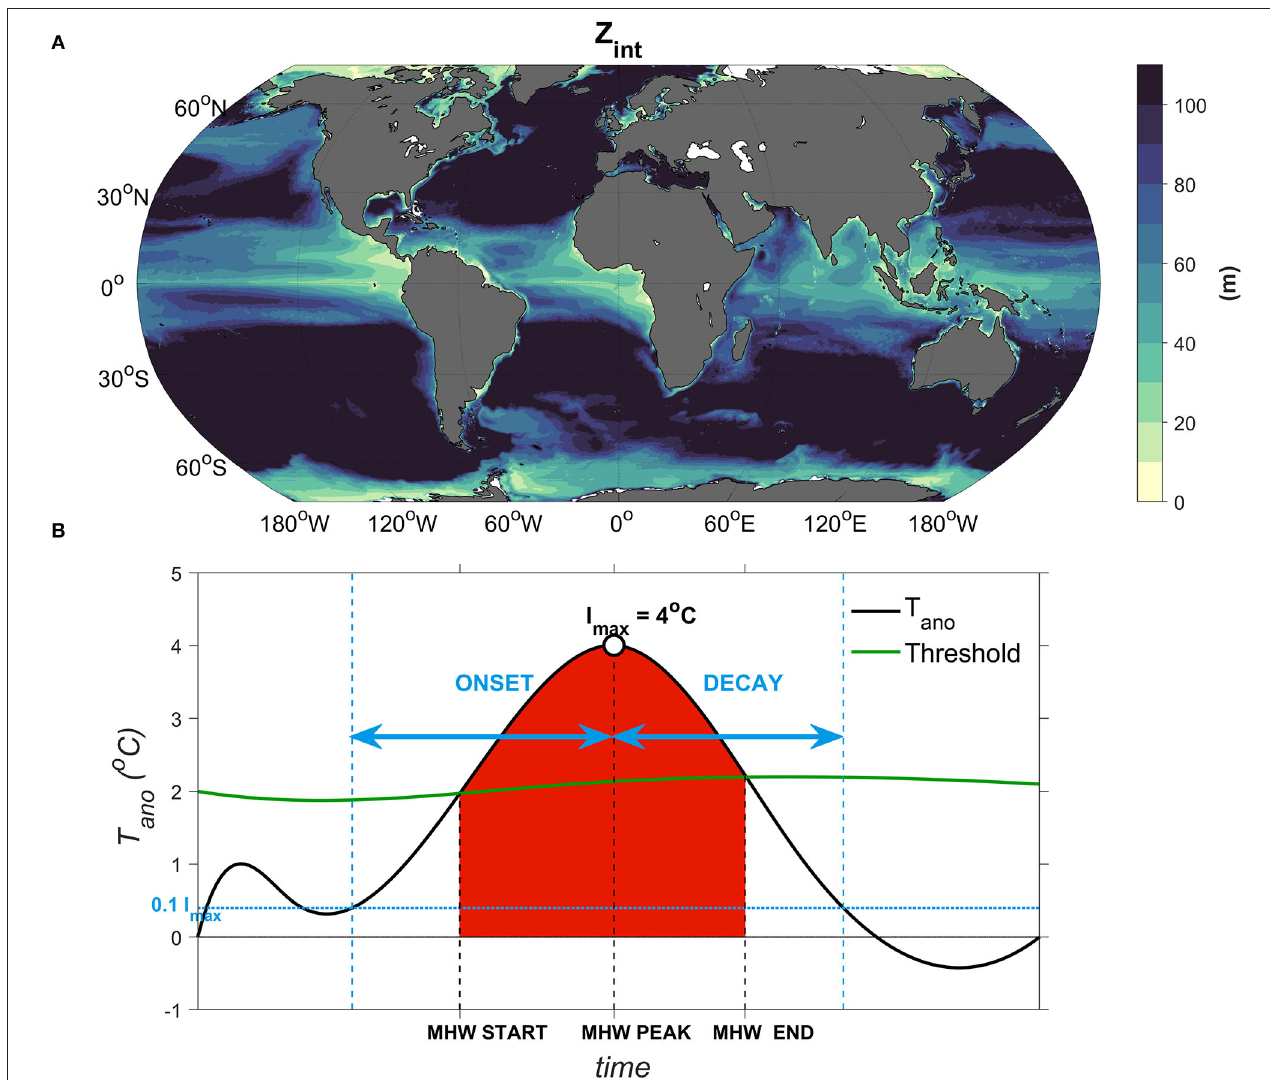
FIGURE 1 | (A) Fixed depth (Zint) used for depth-integration of heat budget terms. Monthly climatology of mixed layer depth was derived from monthly outputs of density-based mixed layer depth at each pixel. The maximum from the monthly climatology were chosen as our fixed depth of integration. Note that Zint was capped at 110m. (B) Schematics of the methodology used to identify MHW events, as well as its corresponding onset and decay period. According to Hobday et al. (2016) definition, a MHW occurs when the temperature anomaly (black) relative to an 11-day window climatology is above a threshold (green) defined as the 90th percentile based on the same climatology for a minimum of five consecutive days. Multiple metrics and characteristics are derived, including the maximum intensity (Imax) of the event (maximum temperature anomaly), which is defined as the MHW peak (Hobday et al., 2016). The onset (i.e., build-up of heat) and decay (i.e., dissipation of heat) were defined as periods when the temperature anomaly was above a value corresponding to 0.1 × Imax (blue). This way, the onset and decay periods include a larger portion of the temperature change associated with a